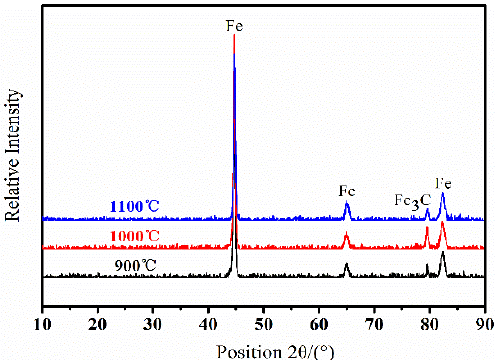
Figure 5. X-ray diffractometer (XRD) patterns of 17Cr2Ni2MoVNb steel quenched at different temperatures.